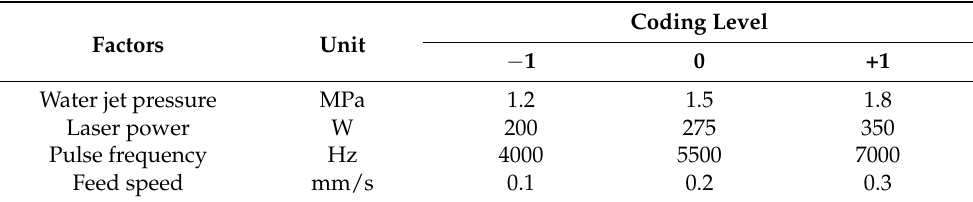
Table 3. Response surface methodology experimental factor level and coding value corresponding